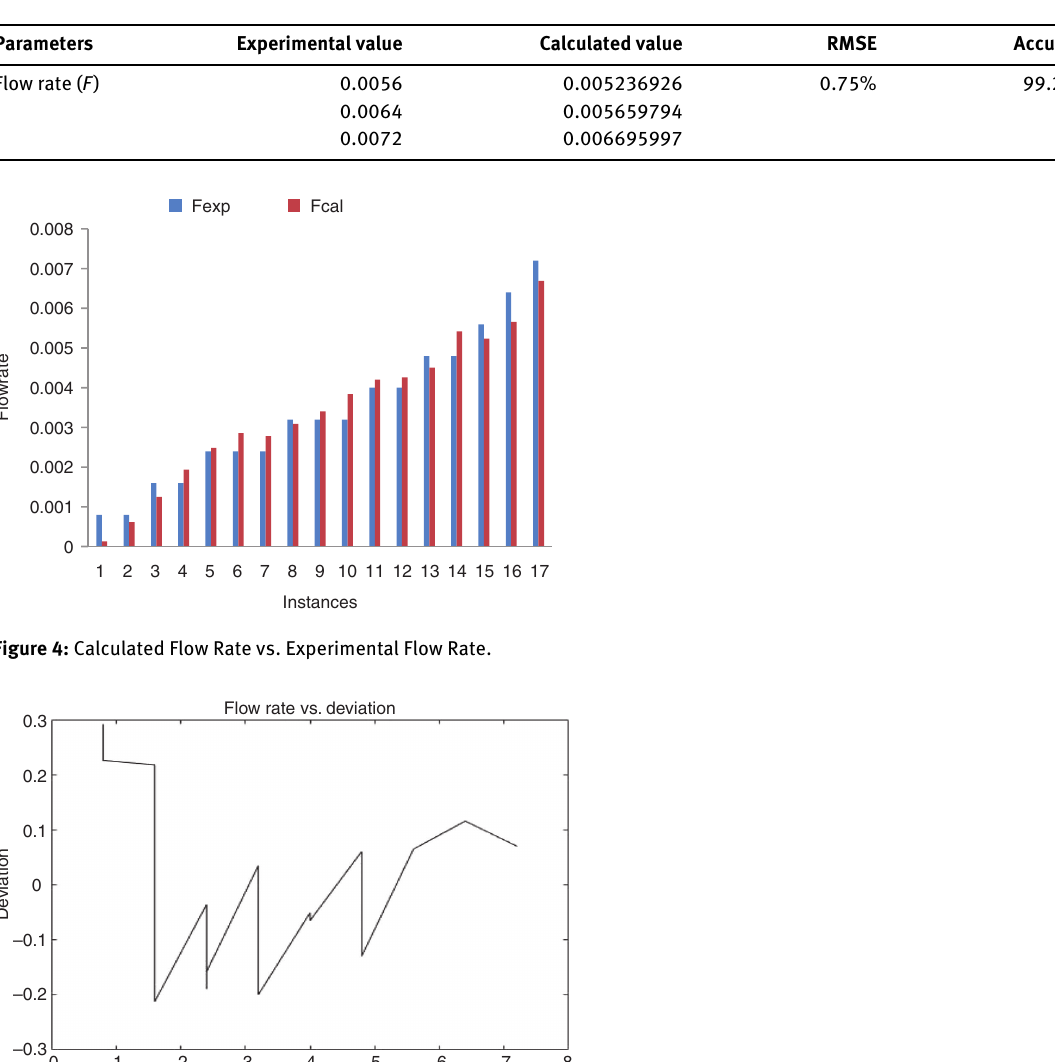
Table 5: Results for Testing New Data.